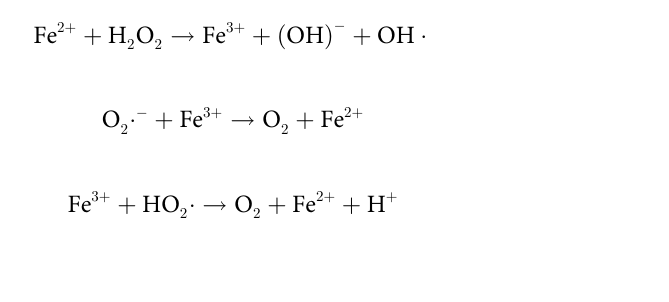
FecA; XOC_3387, vibrioferrin biosynthesis protein PvsA; XOC_3388, vibrioferrin biosynthe- sis protein PvsB; XOC_3389, transport protein; XOC_3390, iron transporter), we inferred that